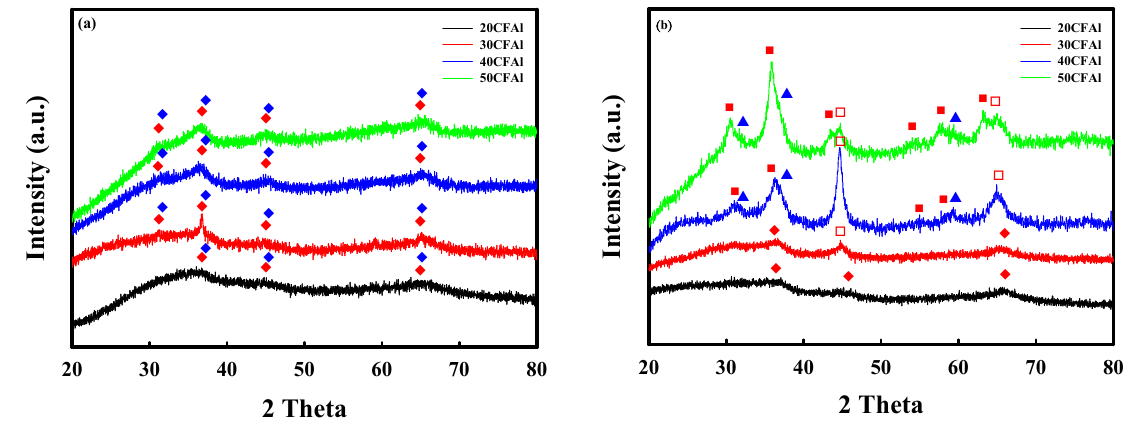
Figure 1. XRD patterns of the calcined and reduced CFAl: ( a ) calcined and ( b ) H 2 -reduced at 500 °C; ( ◆ ) FeAl 2 O 4 , ( ◆ ) CoAl 2 O 4 , ( ▲ ) CoF e 2 O 4 , ( ■ ) Fe 3 O 4 , and ( □ ) Fe metal. H 2 -TPR profiles of the CFAl catalysts with different metal loadings are given in Figure 2. The H 2 -TPR curve of all the CFAl catalysts exhibits two reduction peaks. The low-